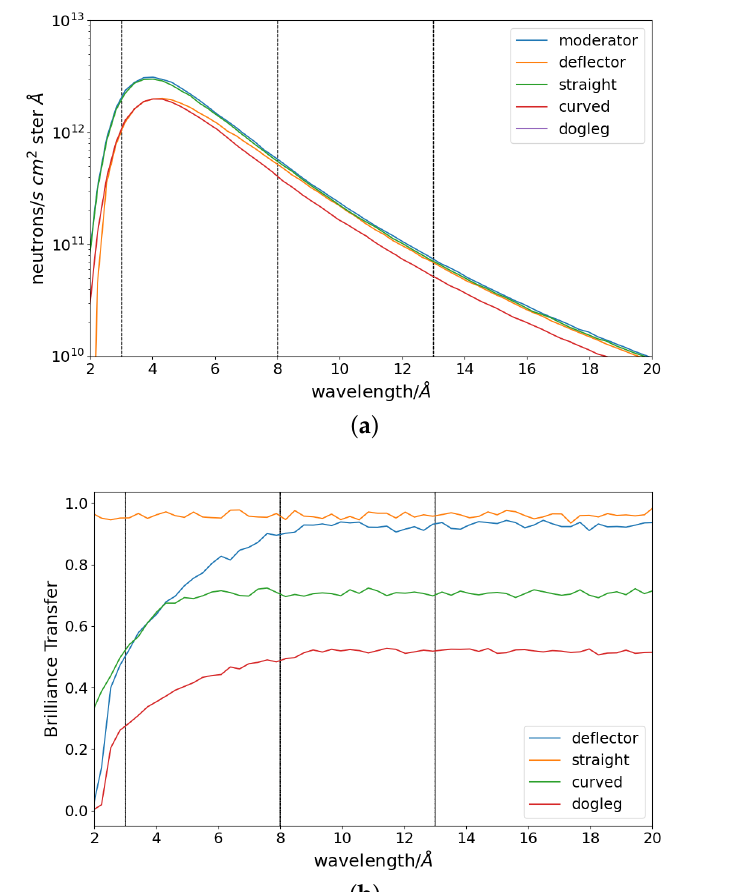
Figure 3. ( a ) Spectra and ( b ) brilliance transfer curves for different solutions of neutron extraction in the case of SKADI. Brilliance transfer was considered for the wavelength shown at divergencies up to 0.0286 ◦ , which corresponds to a 1 cm aperture at a collimation length of 20 m. Because SKADI is a small-angle instrument, performance at the lowest angles is important.